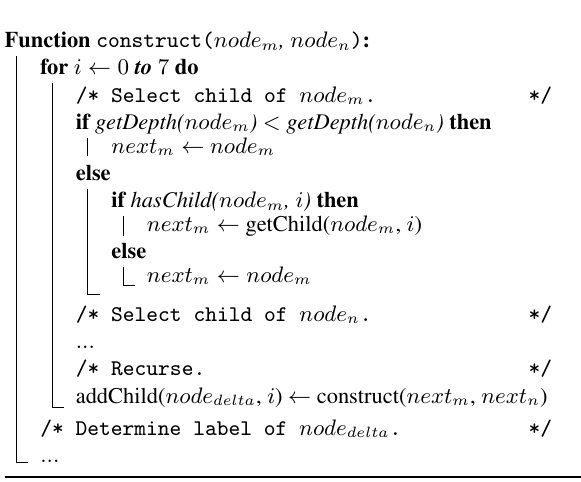
Algorithm 2: Recursive generation of the Delta Octree node delta from two occupancy octrees node m and node n